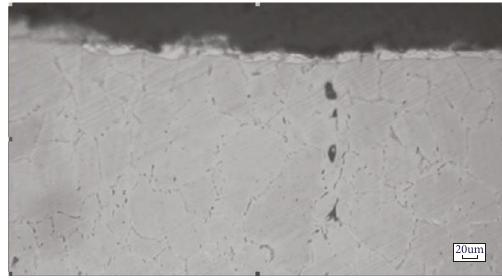
Figure 14: Microphotograph of the recast layer after EDM [23].